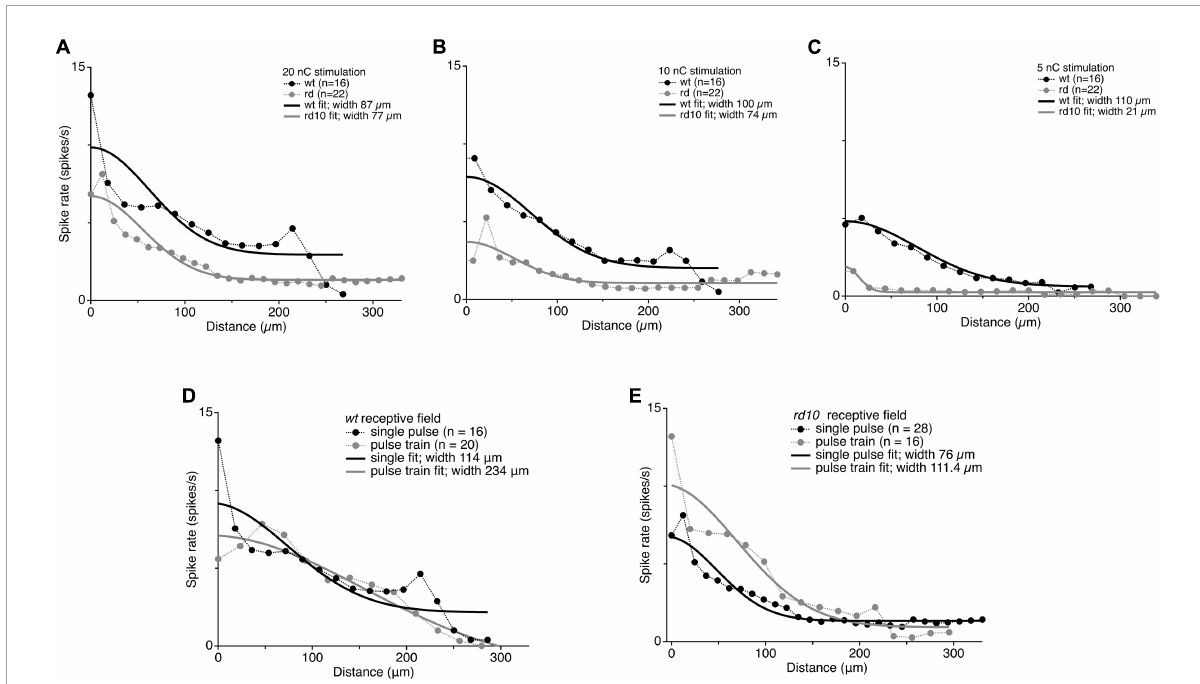
FIGURE9 Comparison of receptive field sizes between wt and rd10 at 20 nC (A) , 10 nC (B) , and 5 nC (C) . Black and gray markers show average evoked spike rates for stimulation plotted against distance from stimulating electrode for wt and rd10 RGCs, respectively. Solid lines show the Gaussian fit to the average spike rates for wt (black) and rd10 (gray). Widths were measured as the 1 standard deviation width of the Gaussian fit. Comparison of receptive field size between a single pulse and a 50 Hz pulse train. (D) Average evoked spike rates for wt RGCs plotted against distance from stimulating electrode for a single 20 nC pulse (black symbols) and for a 200 ms pulse train at 50 Hz, 20 nC per phase (gray symbols). (E) Same as panel (D) , but for rd10 RGCs. Solid lines are the best Gaussian fit to the average data for single pulse (black) and pulse train